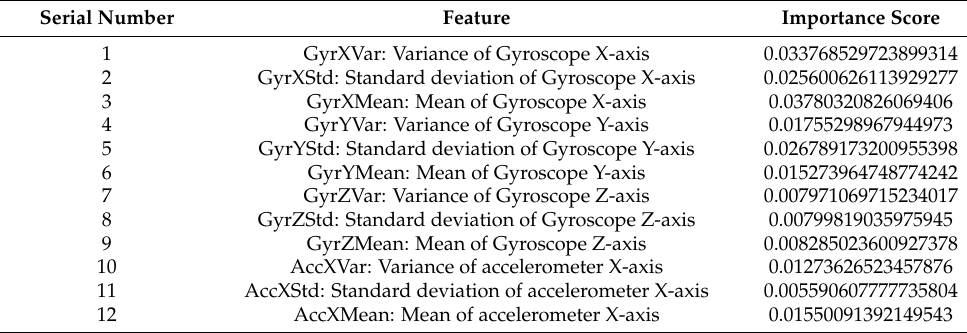
Table 4. All features and their importance scores.